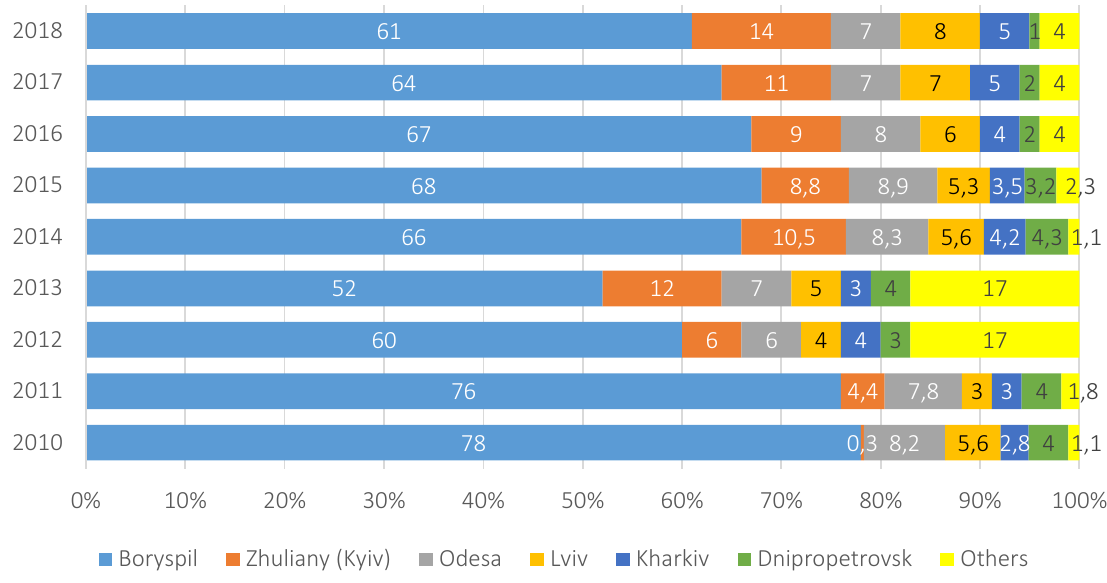
Figure 2. Shares of passengers transported via Ukrainian airports in 2010–2018,